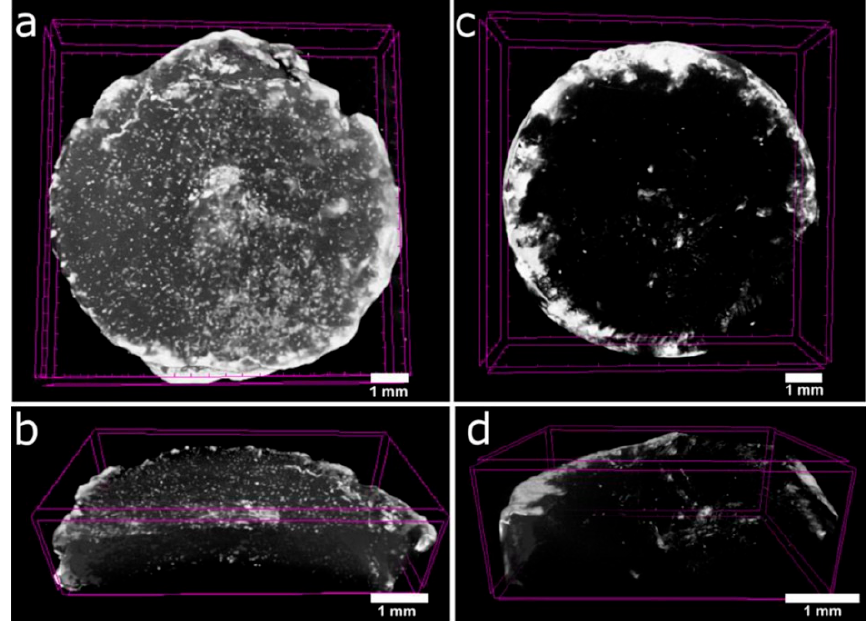
Figure 2. 3D constructed µ CT tomograms of GelMA_5% ( a , b ) and GelMA_10% ( c , d ) scaffolds from day 28 of in vitro culture with MSCs [29]. (Reproduced with permission from Celikkin N et al. Journal of Biomedical Materials Research; published by John Wiley and Sons, 2017.)